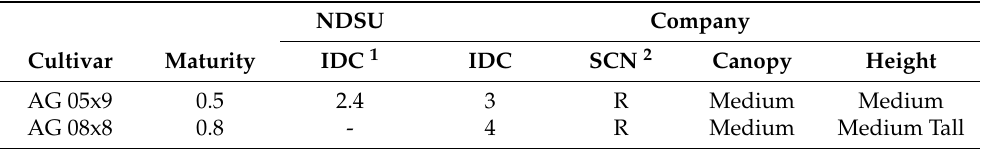
Table 2. Soybean cultivars used and descriptive features.